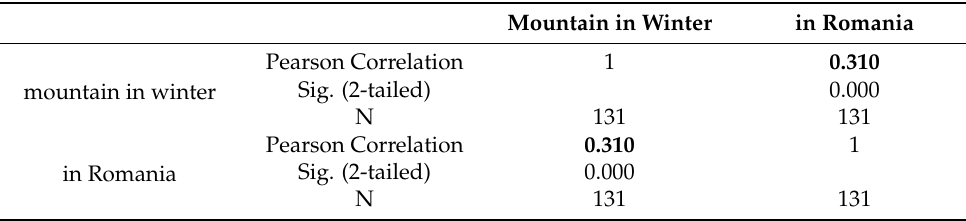
Table 3. Average, positive connection between those who choose mountain destinations in winter and those who choose mountain destinations in their